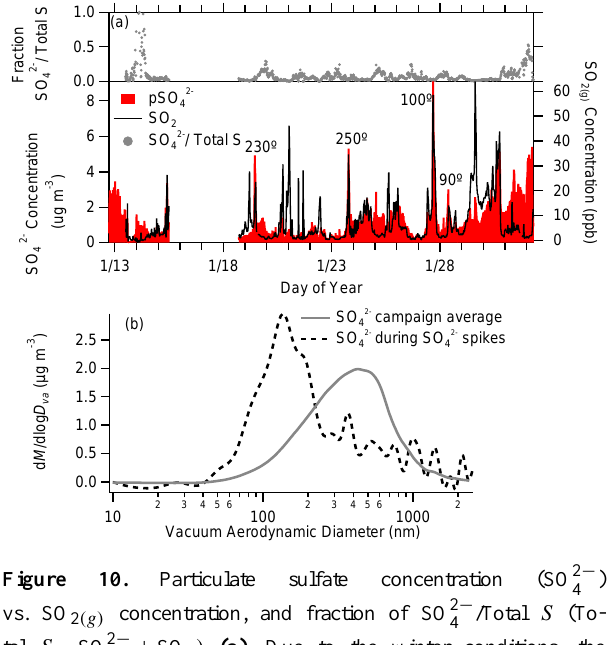
Figure 10. Particulate sulfate concentration (SO 2 − ) 4 vs. SO 2 (g) concentration, and fraction of SO 2 − /Total S (To- 4 + SO tal S = SO 2 − 2 ) (a) . Due to the winter conditions, the 4 fractional contribution of p SO 2 − to total S was typically very 4 low. Shown in (b) are the averaged particle size distributions of AMS SO 2 − over the entire campaign, as well as during the 4 extreme SO 2 − spikes. Particulate SO 2 − measured during the 4 4 spikes appeared highly local due to their significantly smaller modal